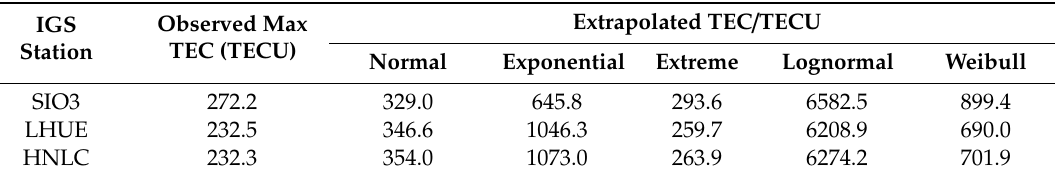
Figure 4. Probability distribution tests of TEC against the Normal (panel a ) and the Extreme Value (panel b ) distributions. The TEC data are from the station HNLC station from 30 October 2003. Red and black broken lines represent normal and extreme value distribution, respectively. Table 3. Maximum TEC values, obtained from inverse cumulative density function (CDF) for a probability bound of 10 − 7 (derived from data of 3 IGS stations from 30 October